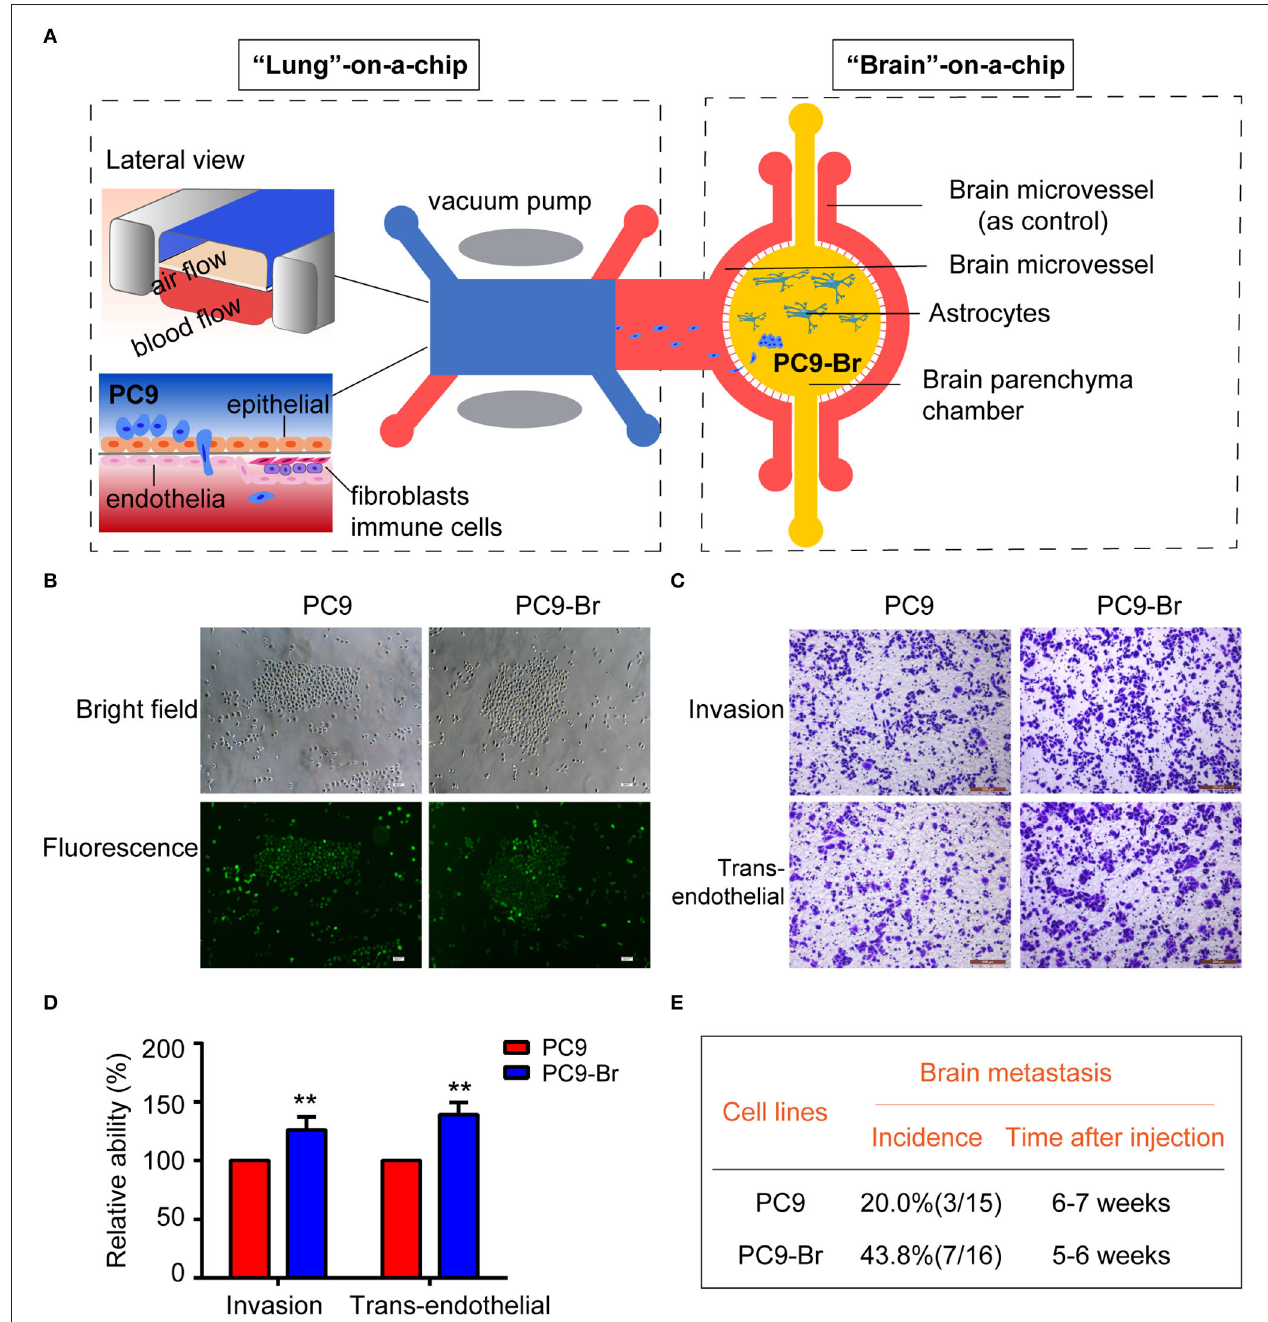
FIGURE 1 | The brain metastatic derivative isolated from BM chip possessed enriched BM activities compared to parental cells in vitro and in vivo . (A) Schematic illustration of the construction and operation of BM process on the multi-organ microfluidic chip as previously described (Liu et al., 2019). (B) Representative co-images of PC9 and PC9-Br cells under the bright field and fluorescence. Scar bar, 200 µ m. (C,D) Representative images showing the invasion and trans-endothelial migration of the PC9 and PC9-Br cells on the Transwell (scale bar, 200 µ m). n = 3, ** p < 0.01. (E) Frequency and time circle of BM after inoculation of PC9 or PC9-Br cells in nude